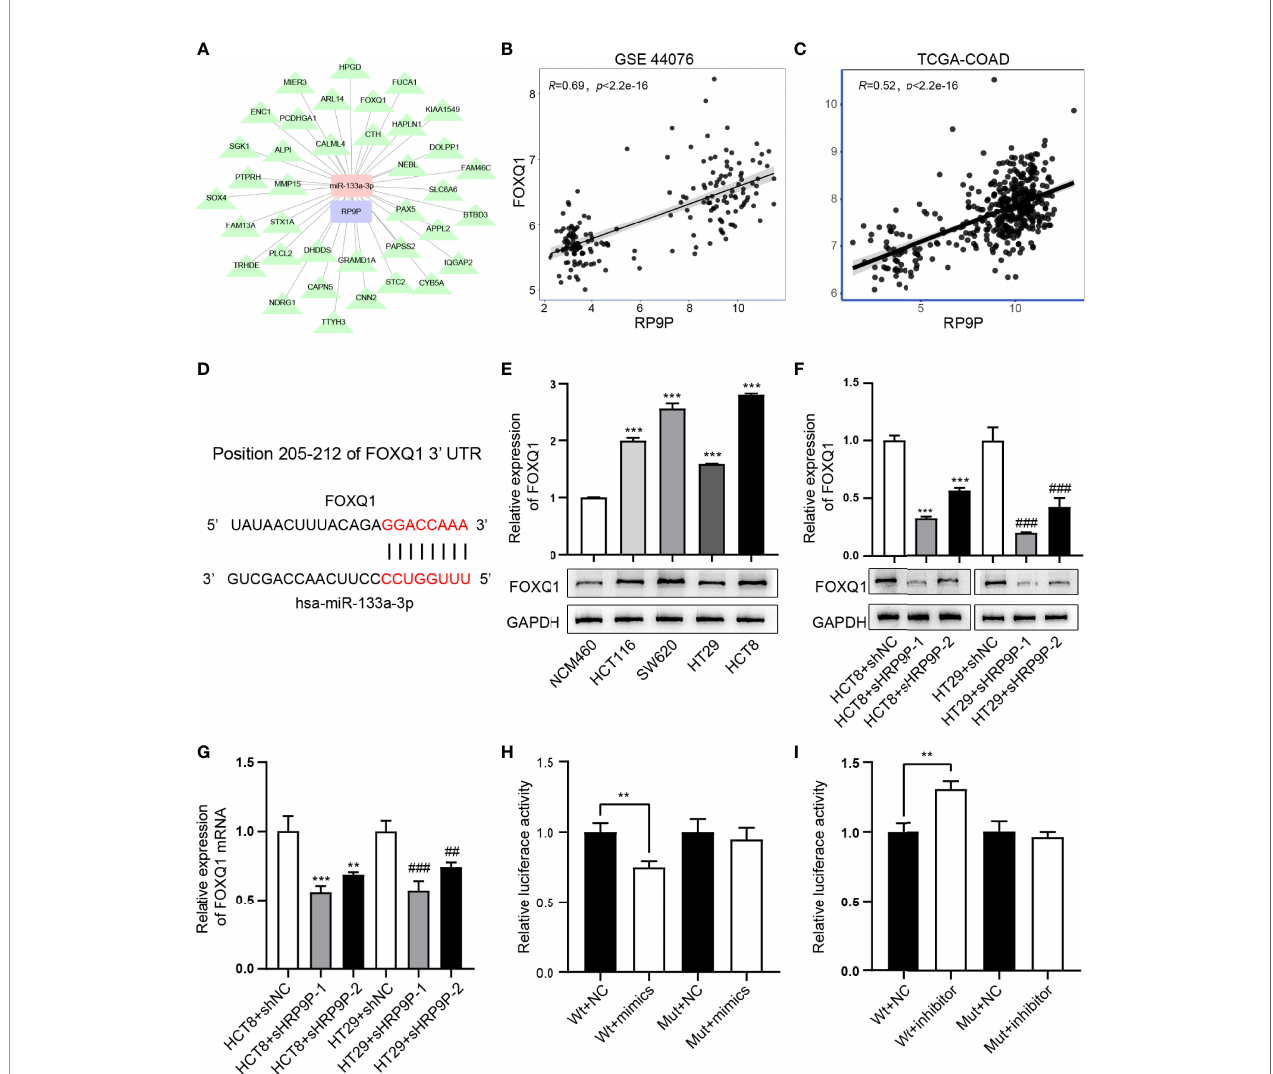
FIGURE 6 | miR-133a-3p directly binds to FOXQ1. (A) Target genes of miR-133A-3p with RP9P as the center were constructed using cytoscape. (B, C) The relationship between FOXQ1 and miR-133a-3p was analyzed using GSE44076 (B) and TCGA-COADREAD (C) data. (D) Predicted binding sites of miR-133a-3p and FOXQ1, and mutated sites in the 3 ′ -untranslated region (3 ′ -UTR) of FOXQ1 . (E) FOXQ1 level in colorectal cancer (CRC) cell lines detected through western blotting (*** p < 0.001 vs. NCM460 cells). F,G. Protein and mRNA expression of FOXQ1 in CRC cells with RP9P knockdown was detected using western blotting (F) and real-time PCR (G) , respectively (** p < 0.01, *** p < 0.001 vs. HCT8 + shNC; ## p < 0.01, ### p < 0.001 vs. HT29 + shNC). H,I. Luciferase activity in nonsense control (NC)-, miR-133a-3p mimic- (H) , and miR-133a-3p inhibitor (I) -treated CRC cells with wild-type or mutant FOXQ1 3 ′ -UTR gene fragments (** p <